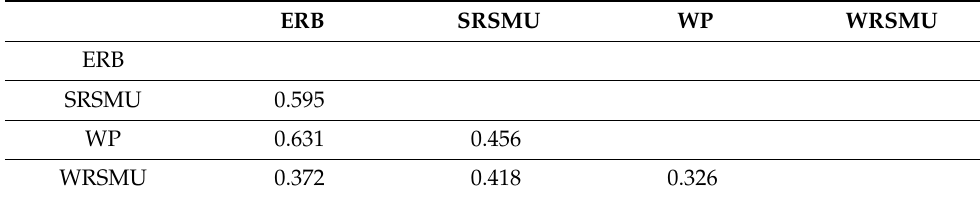
Table 4. Heterotrait–monotrait ratio.